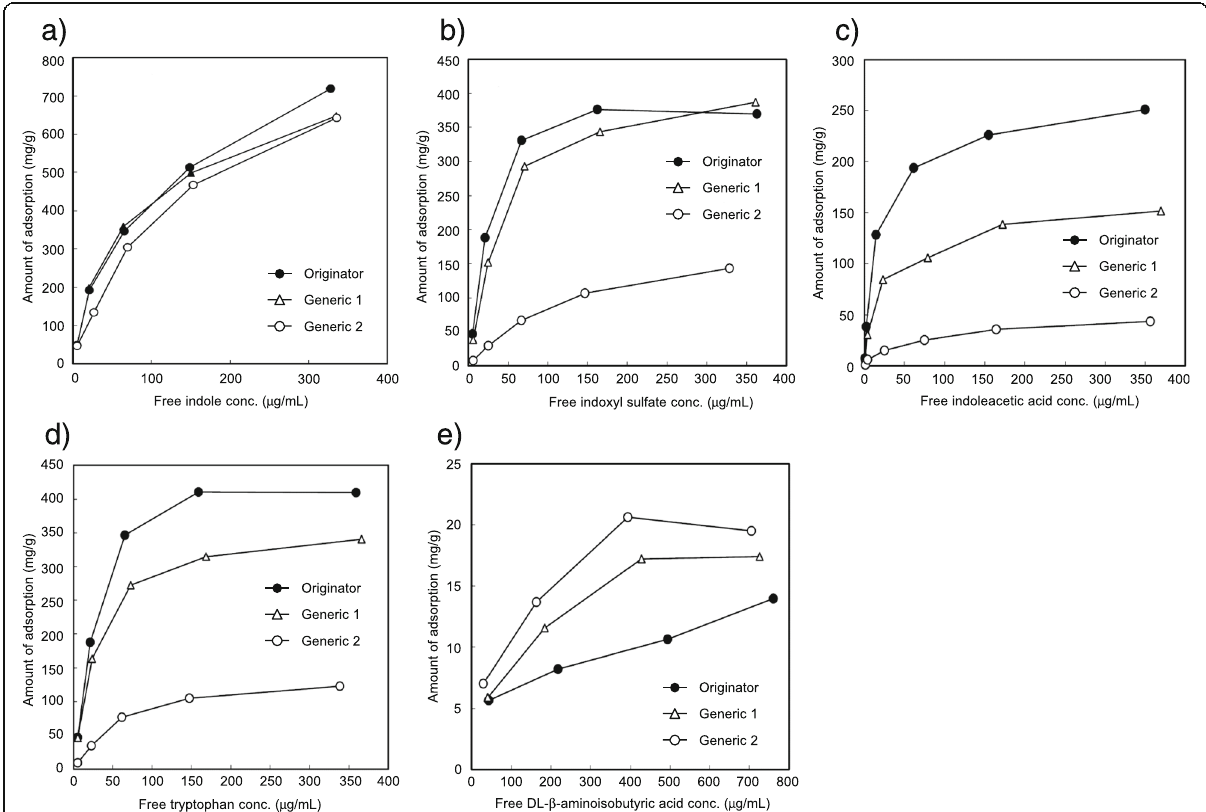
Fig. 2 Adsorption isotherm plots of ( a ) indole, ( b ) indoxyl sulfate, ( c ) indoleacetic acid, ( d ) tryptophan and ( e ) DL- β -aminoisobutyric acid on three spherical adsorbent carbon products. Amount of toxins adsorbed onto spherical adsorbent carbon was calculated from the decreased amount of free toxins in